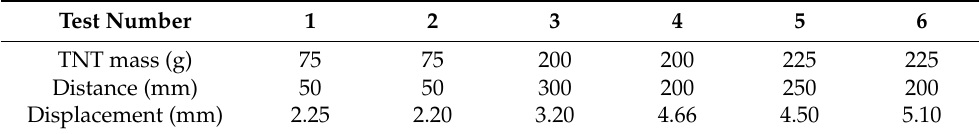
Table 4. Experimental parametric setup with concrete specimen deflection.